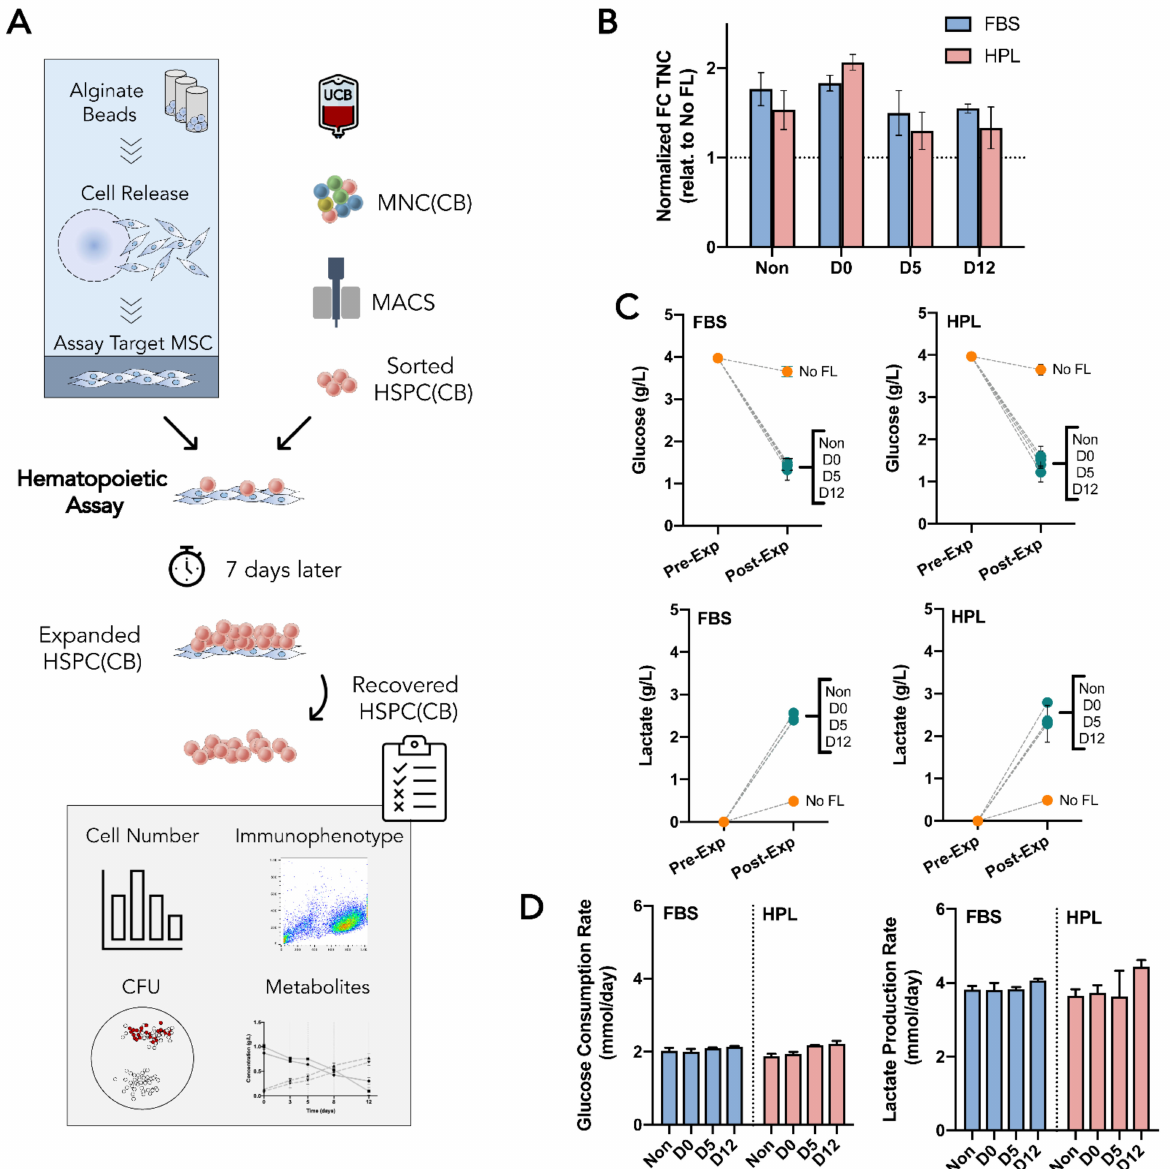
Figure 5. Hematopoietic support assay for MSC(AT) potency/function. ( A ) Experimental lay- out. Non-encapsulated and released MSC(AT) are replated as a feeder layer to investigate their hematopoietic support capacity. Umbilical cord blood-derived hematopoietic stem and progenitor cells (HSPC(CB)) were isolated via magnetic activated cell sorting (MACS) and seeded onto the MSC(AT) feeder layer. After 7 days in a co-culture setting, expanded HSPC(CB) were harvested